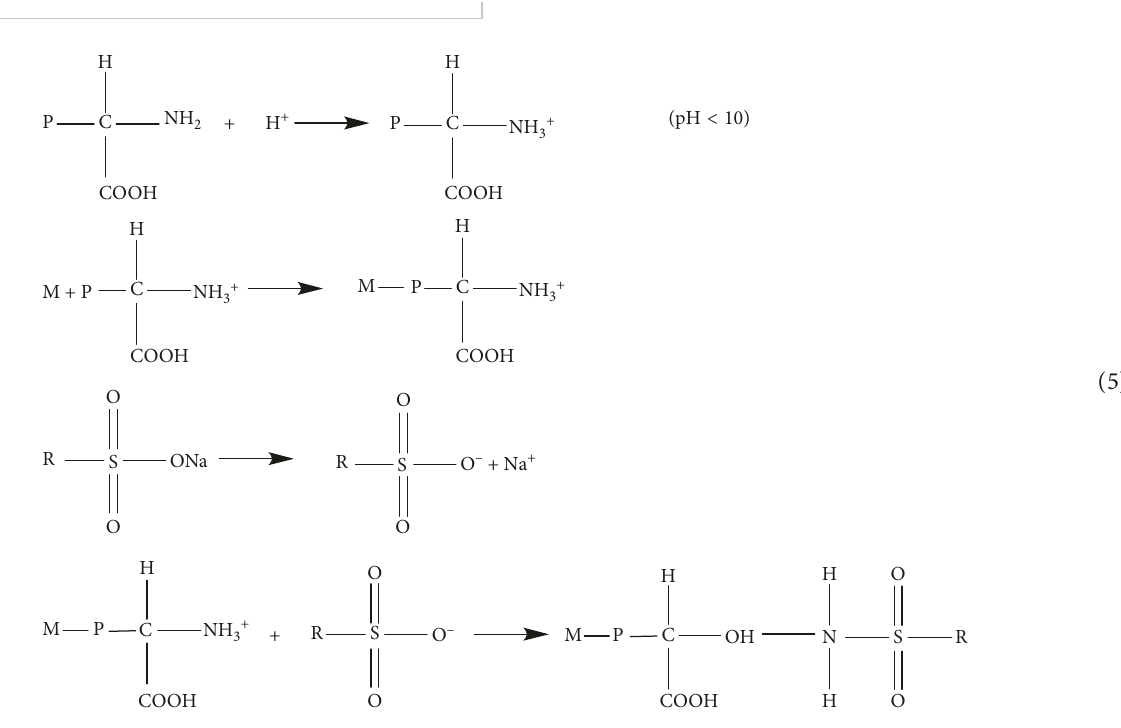
Figure 4: Effect of pH on RR-2 uptake ( C time: